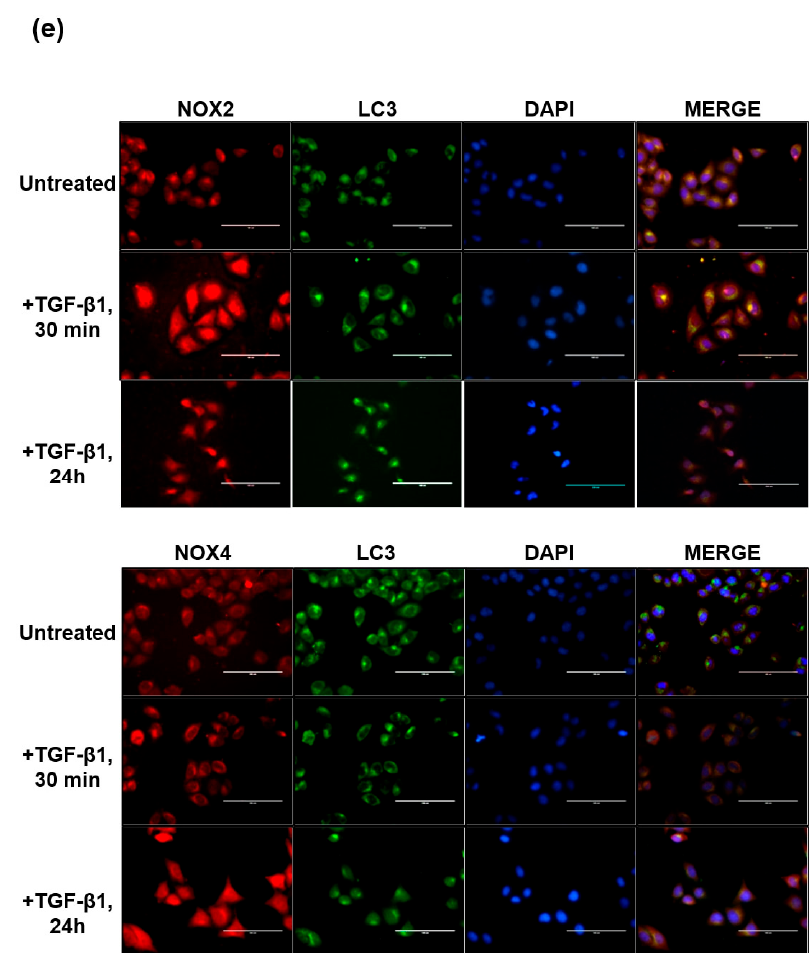
Figure 2. Changes in the expression of NOX2 and NOX4 in the presence of 5 ng/mL TGF- β 1 for 48 h. ( a ) Representative Western blot depicting the time course (0.15, 0.5, 1, 2, 4, 12, 24, and 48 h) of NOX2 and NOX4 expression following TGF- β 1 treatment. ( b ) HeLa cells were treated with TGF- β 1 for 48 h. The expression of NOX2 and NOX4 was examined by RT-PCR. ( c ) TGF- β 1-induced expression and determination of the intracellular co-localization of NOX2 and NOX4 in HeLa cells. NOX2 (red) and NOX4 (green) signals were merged with the cell nuclear dye DAPI (blue). NOX2 and NOX4 expression and intracellular location in untreated cells and cells treated with TGF- β 1 for 30 min and 24 h cells are shown. The images were quantified using ImageJ. Generation of the graph and statistical analysis were carried out using Excel. ** p < 0.01, * p < 0.05. ( d ) Co-localization of NOX2 (green), NOX4 (green), and EEA1 (red) in cells treated with TGF- β 1. Cells maintained in the presence or absence of TGF- β 1 for 30 min or 24 h were visualized by immunocytochemistry. ( e ) Co-localization of NOX2 (red), NOX4 (red), and LC3 (green) in cells stimulated with TGF- β 1 (0, 30 min, and 24 h). Nuclei were stained with DAPI. Scale bar in (c–e) represents 100 µm.